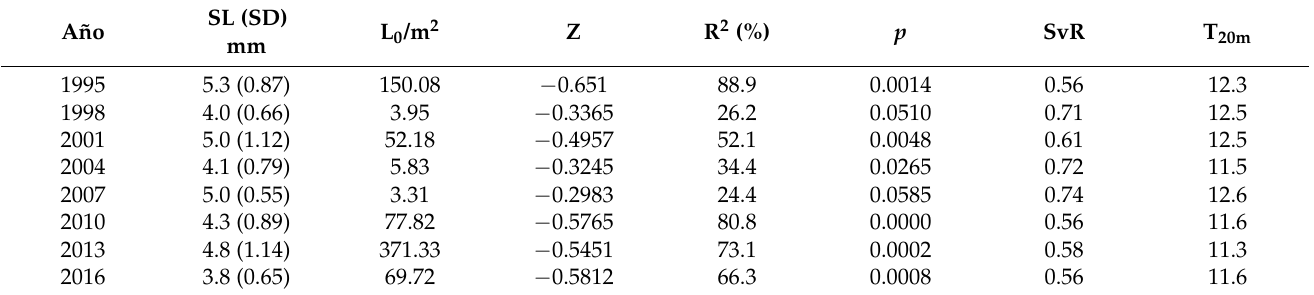
Table 5. The parameters of the mortality exponential model fitted to the data of hake larvae abundance (number/m 2 ) by 1 mm length (mm). SL: Average larval length; SD: Standard deviation; Lo: Larval abundance at hatch; Z: Instantaneous mortality; R 2 : Coefficient of determination; p : Significant level; SvR: Survival rate; and T 20m : Temperature at 20 m depth (°C).